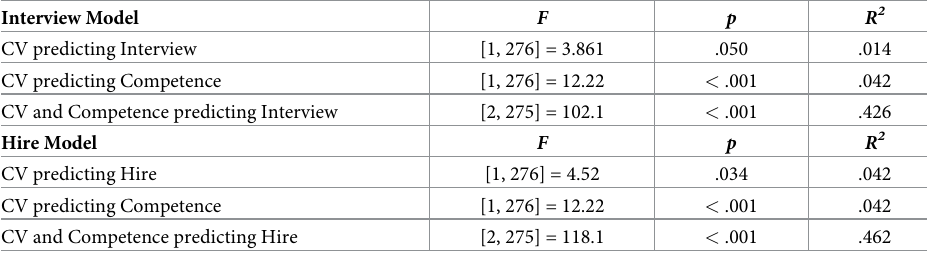
Table 4. Model summaries for mediation